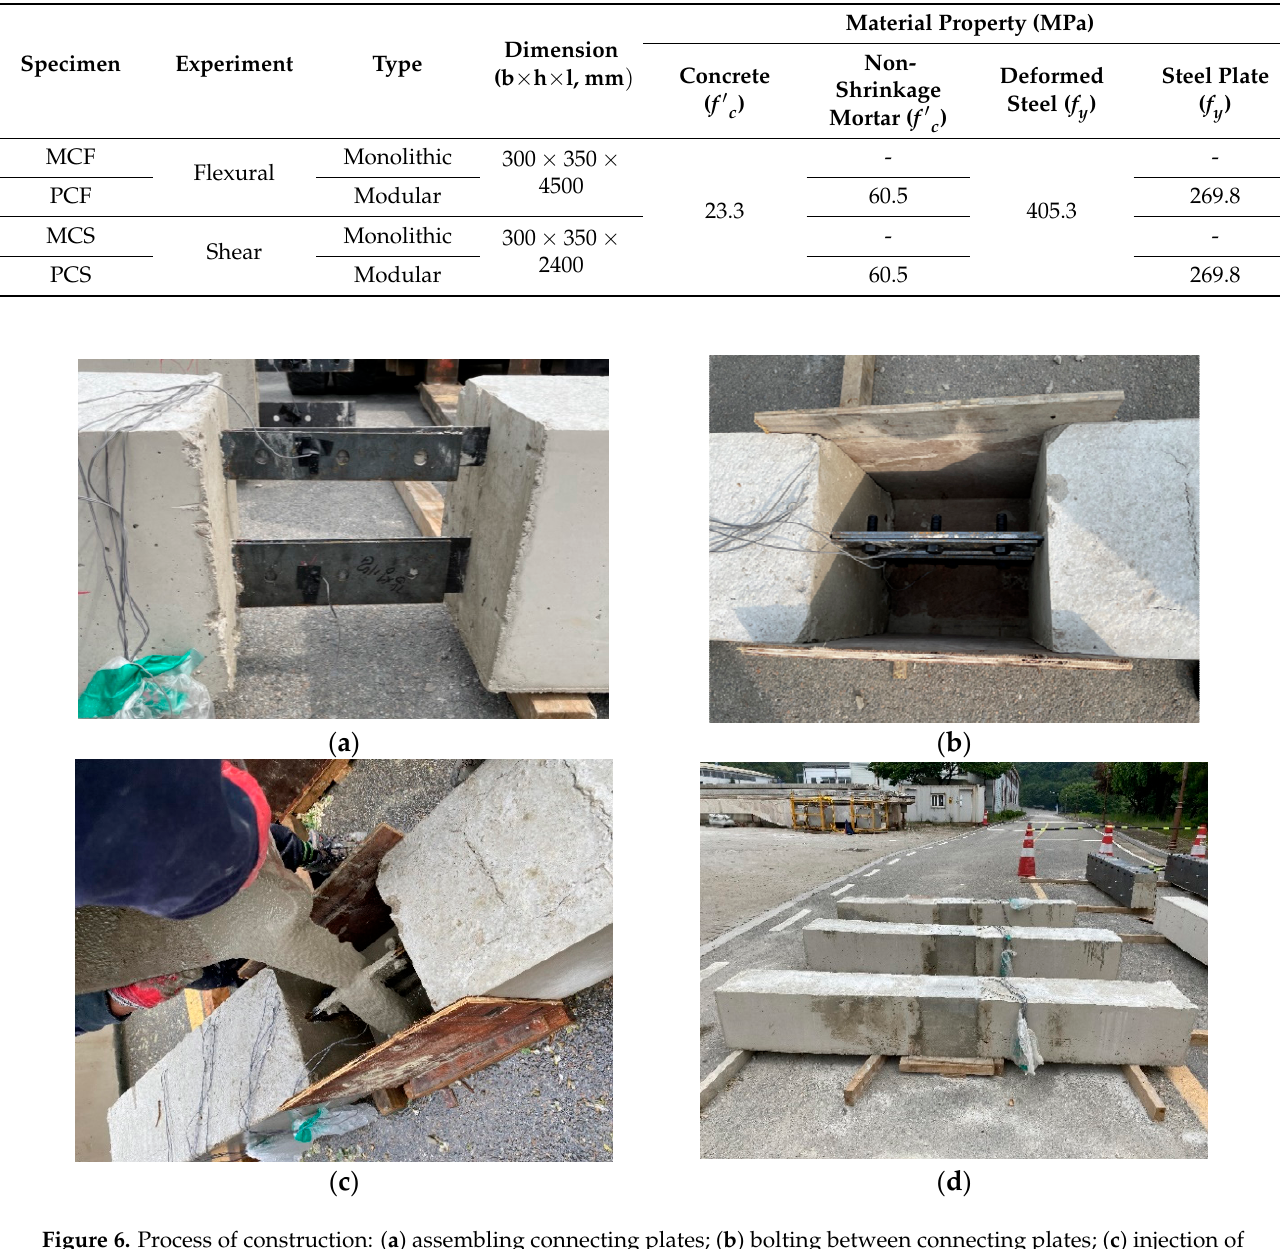
Figure 6. Process of construction: ( a ) assembling connecting plates; ( b ) bolting between connecting plates; ( c ) injection of non-shrink mortar. ( d ) Removal of concrete form.